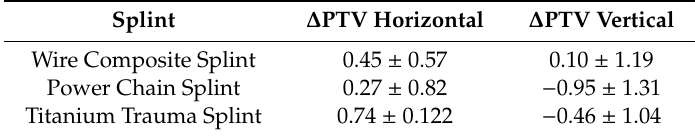
Table 10. Splint e ff ects ( ∆ PTV) for lateral